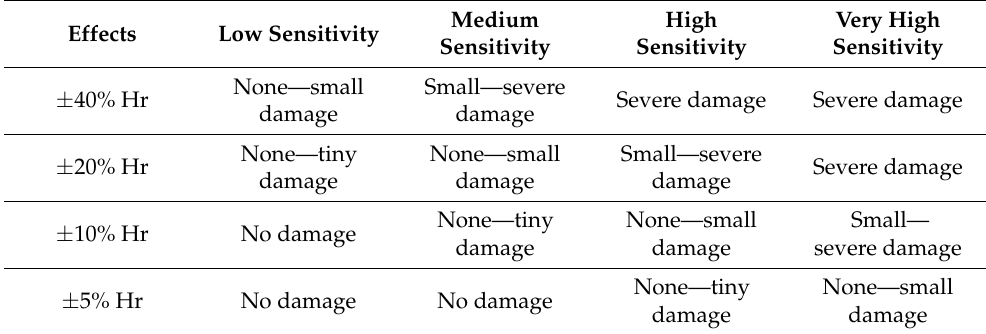
Table 1. Effects of fluctuations in relative humidity (Hr). Source: